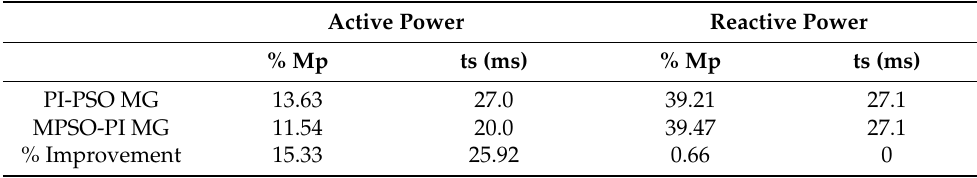
Table 5. Transient response analysis for load